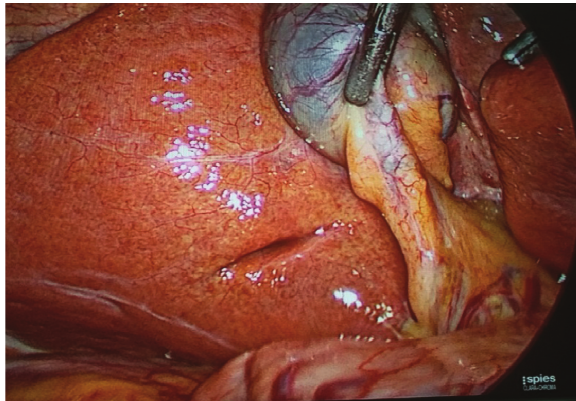
Figure 4: Absence of RS.